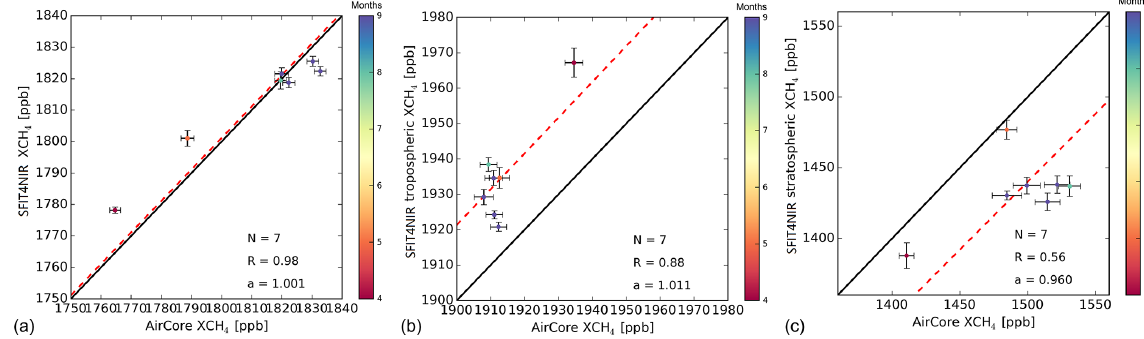
Figure 11. The scatter plots of X CH between the SFIT4NIR and the AirCore measurements for the whole atmosphere (a) , and for the 4 tropospheric (b) and stratospheric (c) components. In each panel, the black line is the one-to-one line and the dashed red line is the regression line with the intercept to zero ( y = a · x ). N is the co-located measurement number, R is the correlation coefficient, and a is the